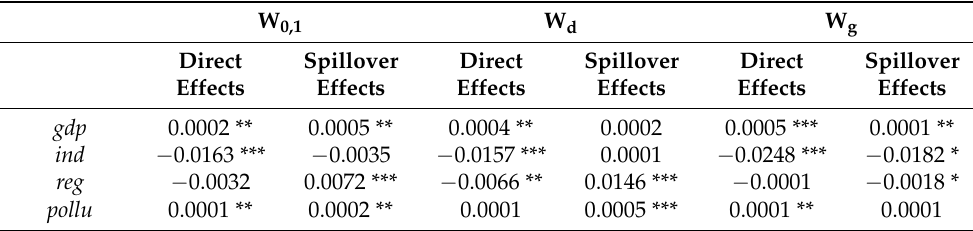
Table 6. Influencing factors’ spatial spillover